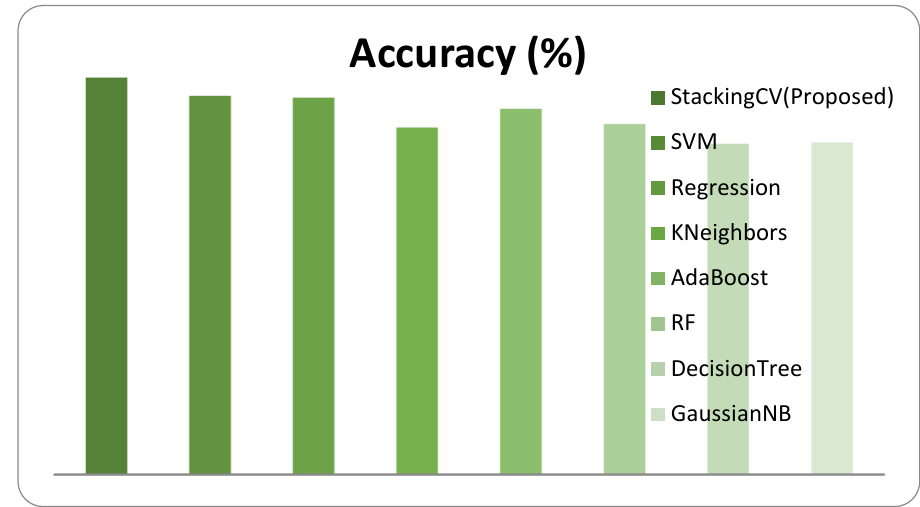
Figure 10. Performance of the system for Xception features.